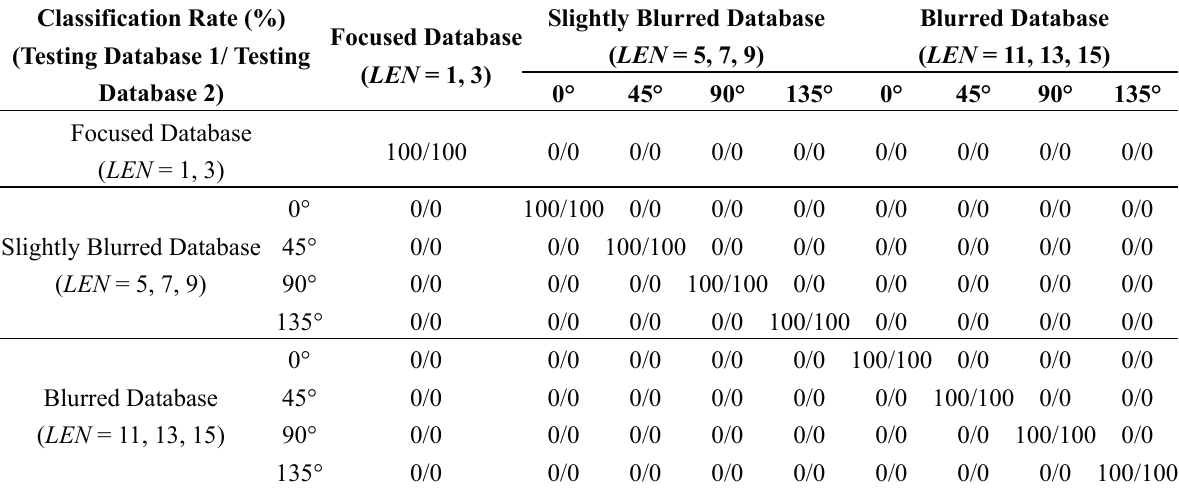
Table 7. Estimation results of motion blur database using our estimation method for motion blur